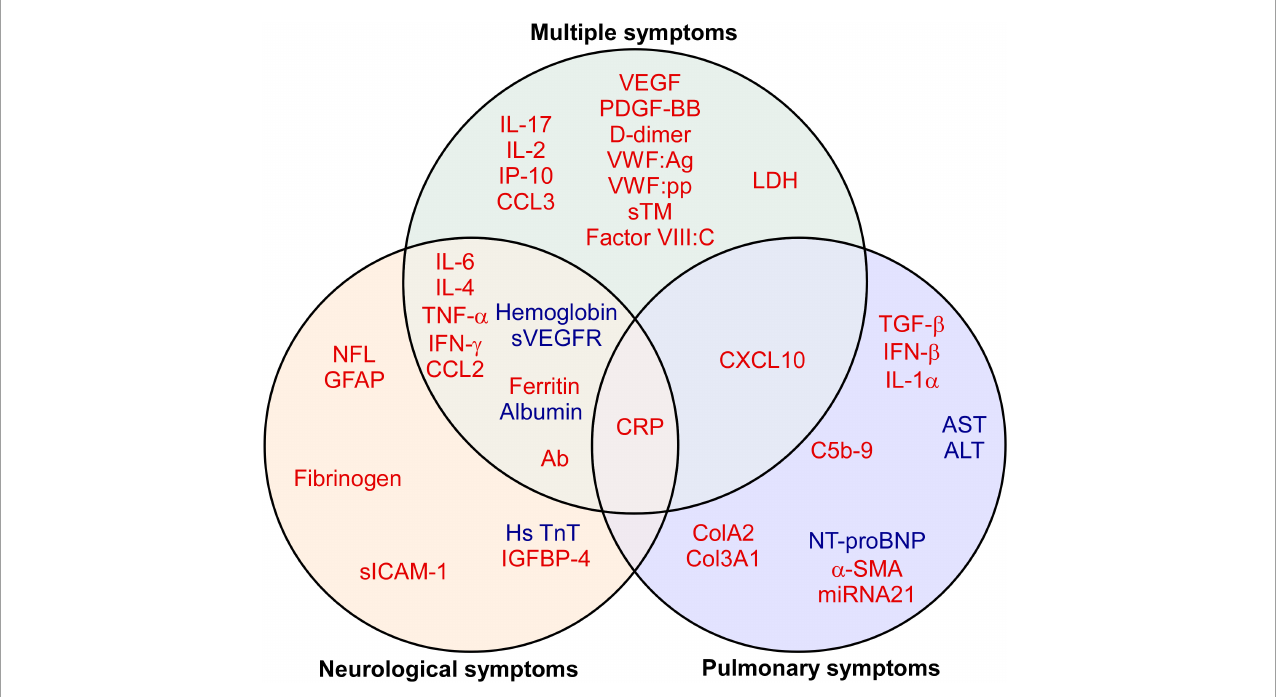
FIGURE4 Biomarkers of long COVID symptoms. The Venn diagram presents the 41 biomarkers that were reported by two or more eligible studies. Red indicates up-regulated, while blue refers to down-regulated biomarkers. A detailed list of abbreviations in Figure 4 can be found in Supplementary Table 2